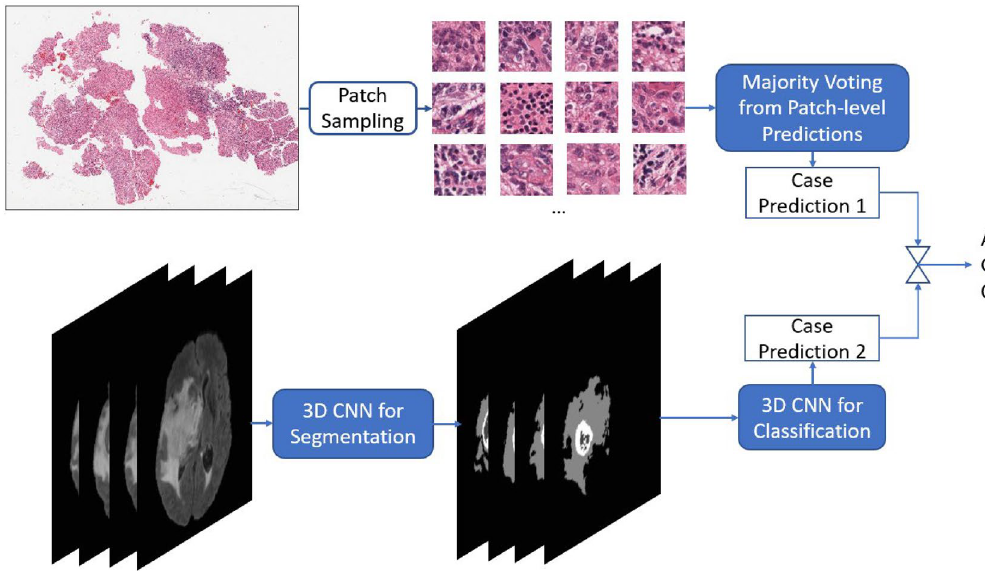
Figure 1. Overall pipeline of the proposed method in inference phase.